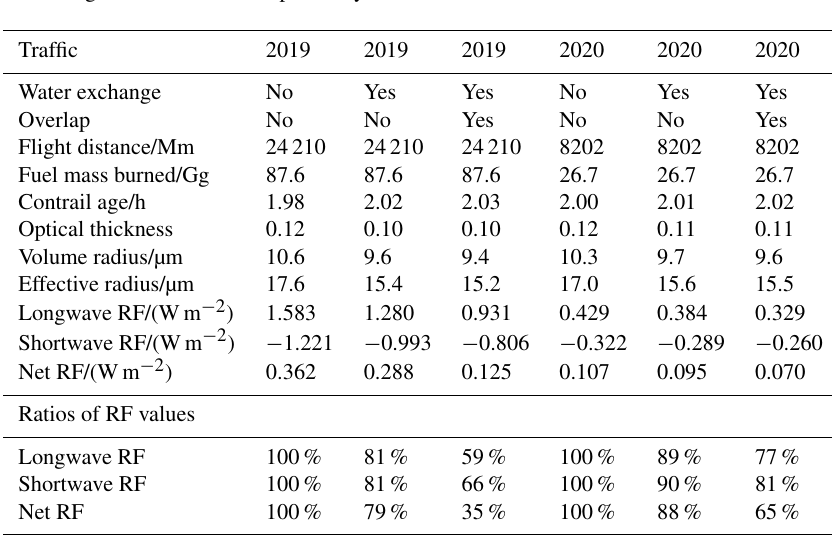
Table 8. Effects of water exchange and contrail overlap for July